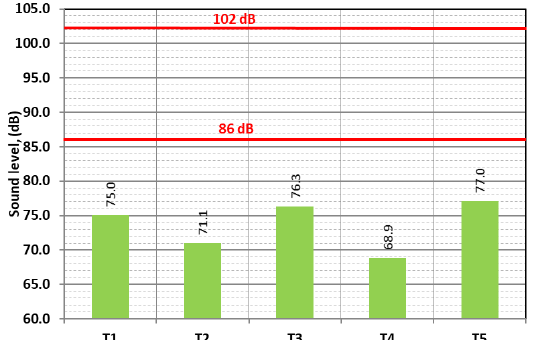
Figure 21. Equivalent noise levels weighted by the G curve recorded at the tested turbines T1, T2, T3, T4 and T5 along with the permissible levels of infrasound noise in the working environment specified in the PN-Z-01338 standard.